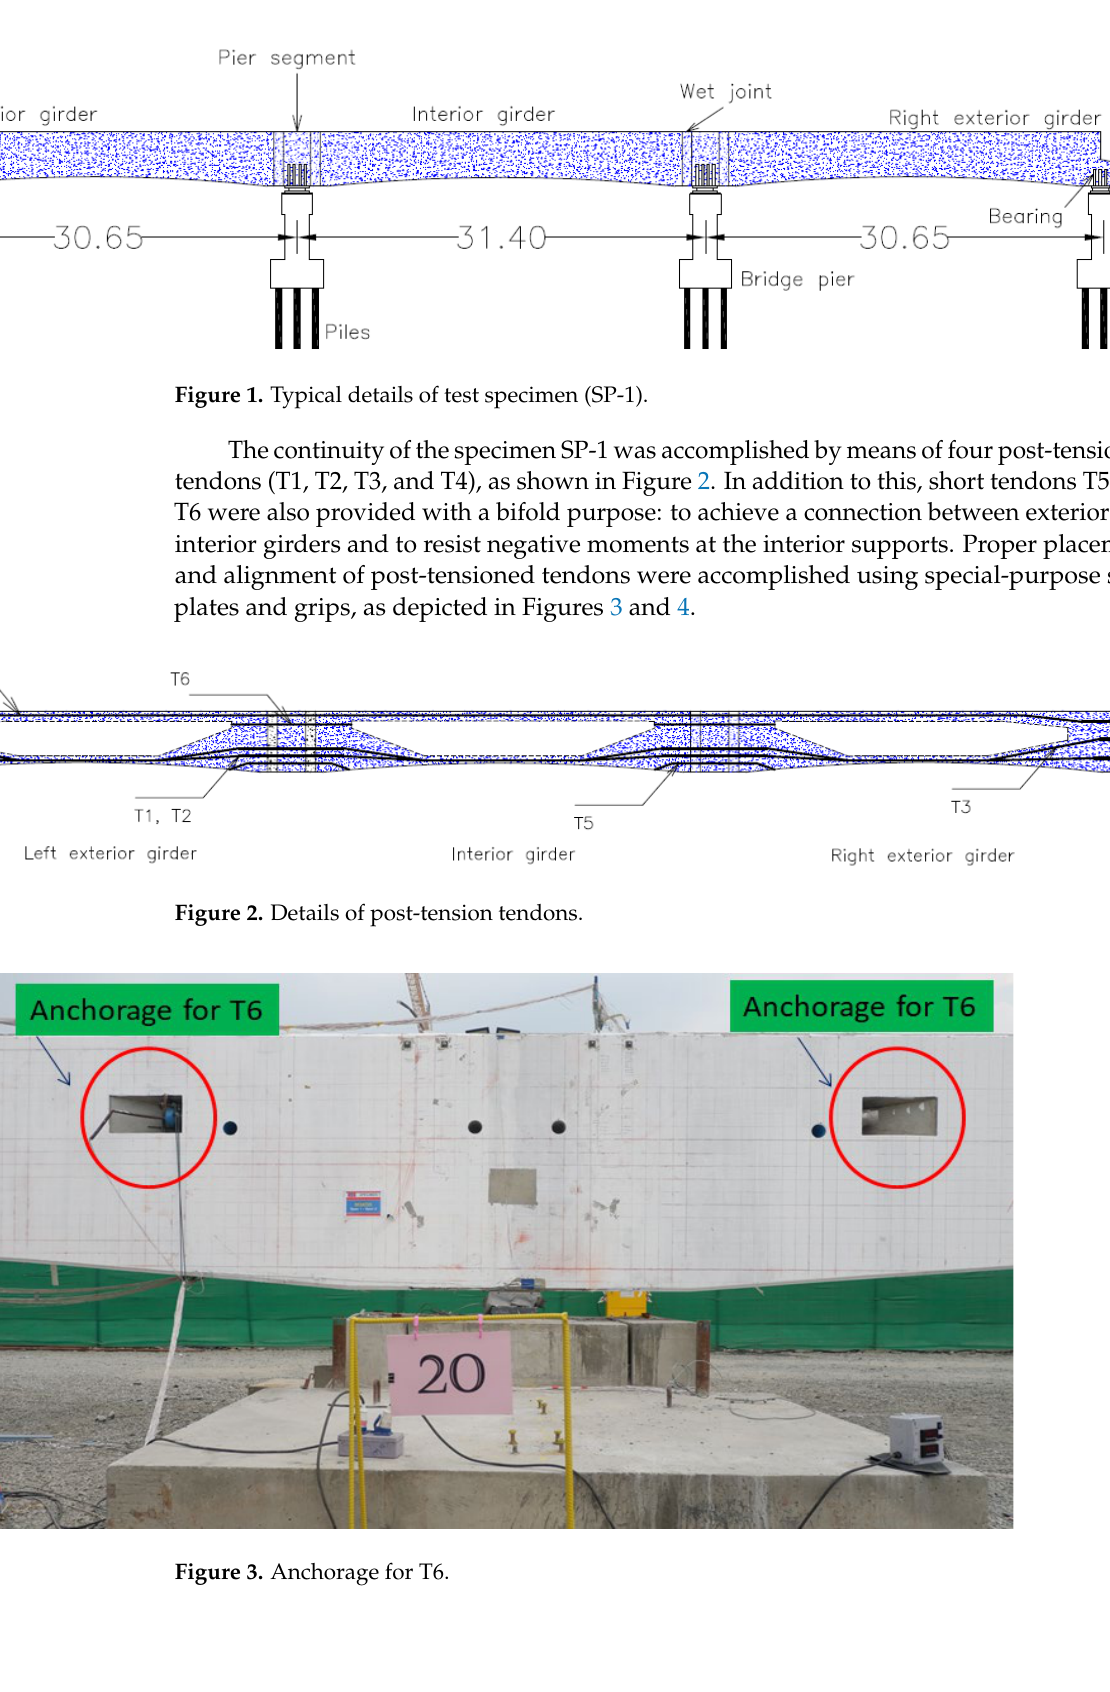
Figure 4. Application of tension to the PT tendons. 3. Material Properties All components in each specimen were constructed using high-strength ready-mixed concrete. Concrete cylinders of dimensions 150 mm × 300mm were cast to determine the compressive strength of the concrete, as per the recommendations of ASTM C39/C39M–21 [16]. Mix proportions of the concrete are given in Table 1, while average values of compressive strength for each component are presented in Table 2. All the reinforcement comprised deformed steel bars. Mechanical properties of the deformed steel bars for each size were evaluated as per the provisions of ASTM A615/A615M [17]. Table 3 enlists the yield and tensile strengths of the steel bars. Post-tensioned ducts were filled with a special cement grout whose properties were evaluated by performing com- pressive tests on standardized 50 × 50 mm cubes, as per ASTM C109/C109M–21 [18]. Ta- ble 2 also presents the compressive strength of the cement grout.